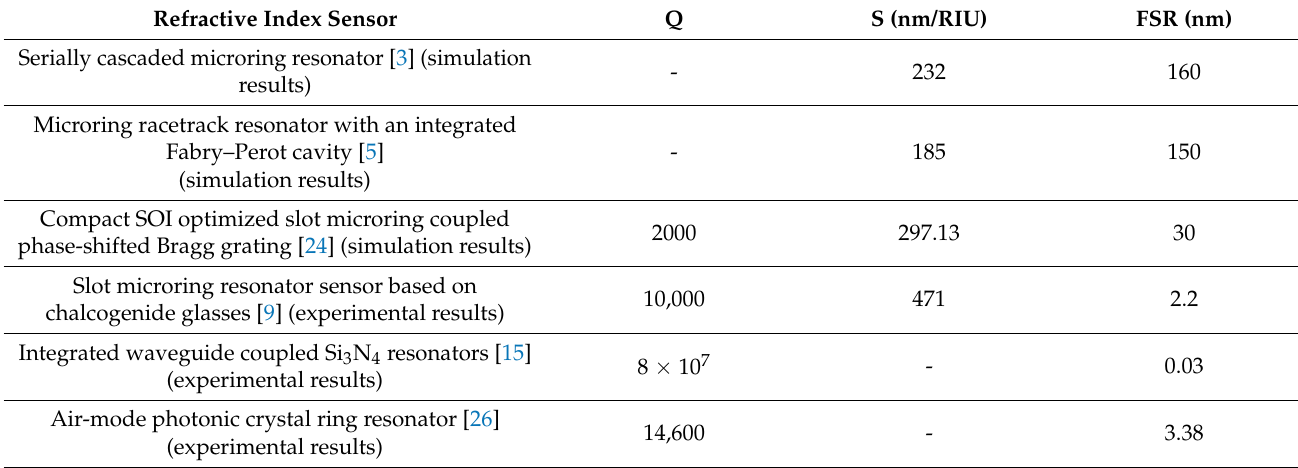
Table 1. Comparison of three parameters of refractive index